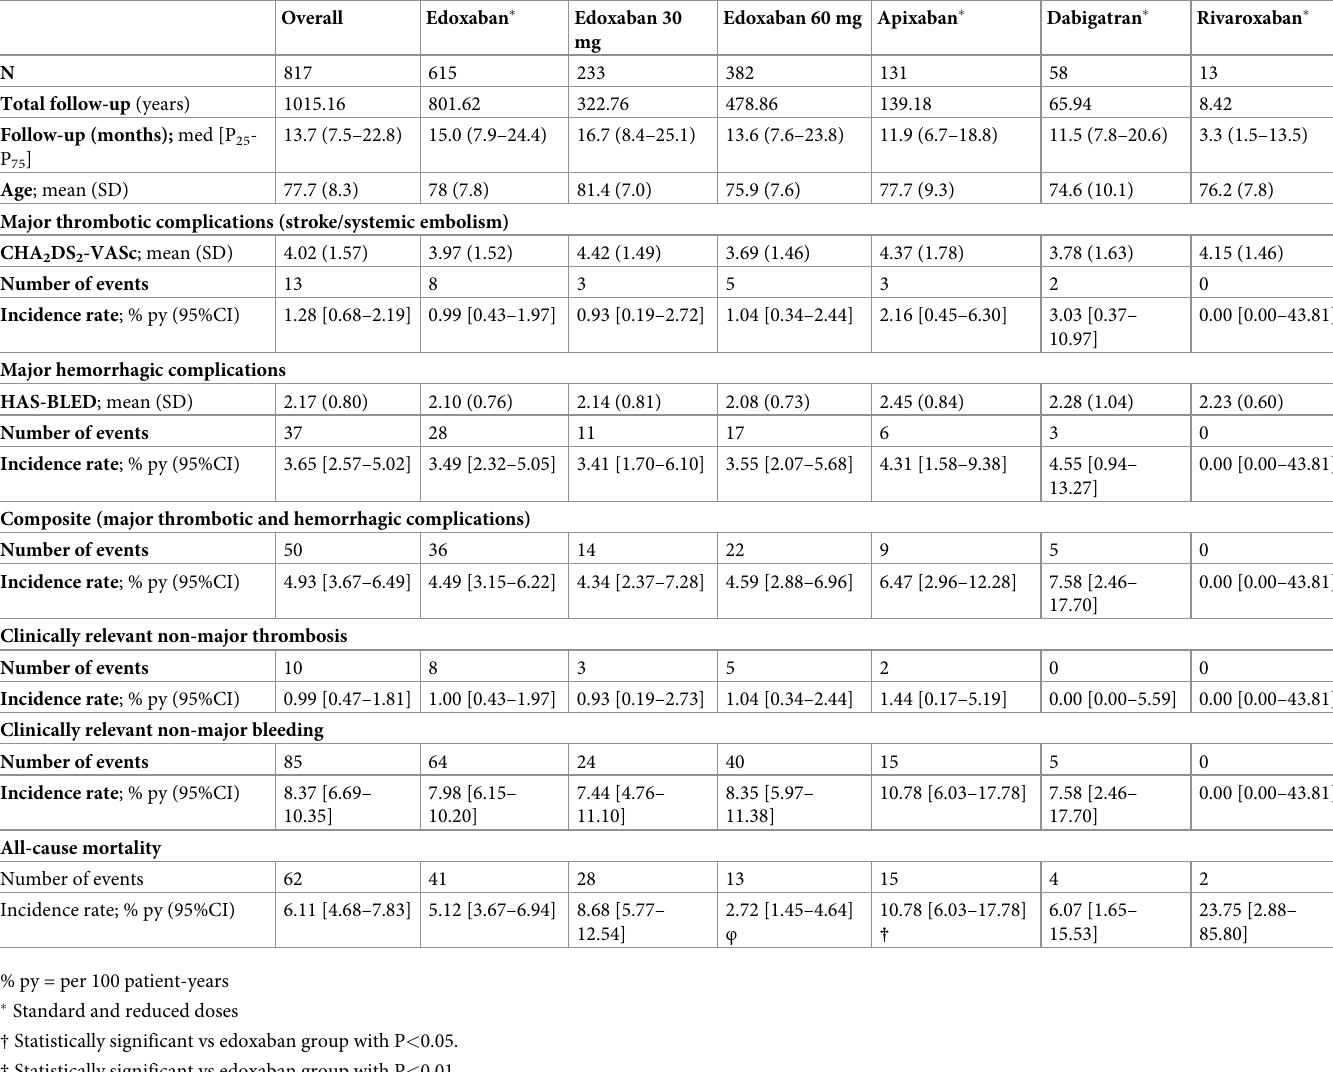
Table 2. Complications according to DOAC